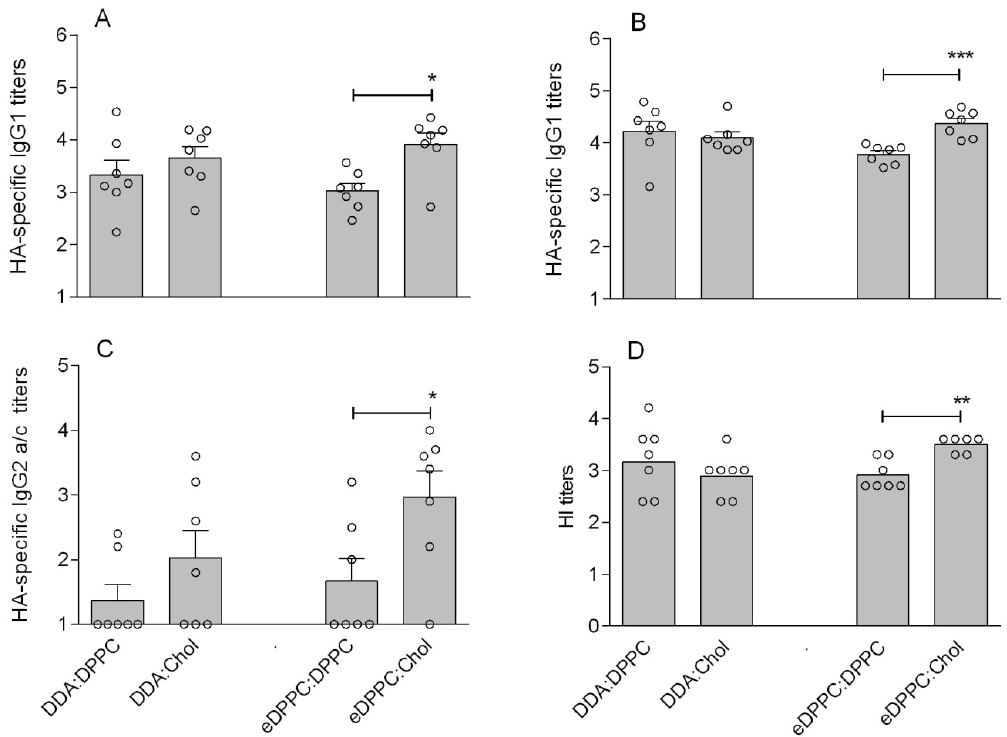
Figure 3. Immune response in mice vaccinated with 2.0 µg HA, either free or mixed with liposomes with or without Chol: HA-specific serum IgG1 after prime ( A ) and boost ( B ); IgG2a/c after boost ( C ); and HI titer after boost ( D ). For panels A–C, each dot represents the log serum titer of an individual mouse (non-responding mice were given an arbitrary titer of 10) and bars represent average log titer + SEM. For panel D, each dot represents the log HI titer in serum of an individual mouse and bars represent the geometric mean. Significant differences between the groups treated with the liposomal formulations are indicated with * ( p < 0.05), ** ( p < 0.01), or *** ( p <